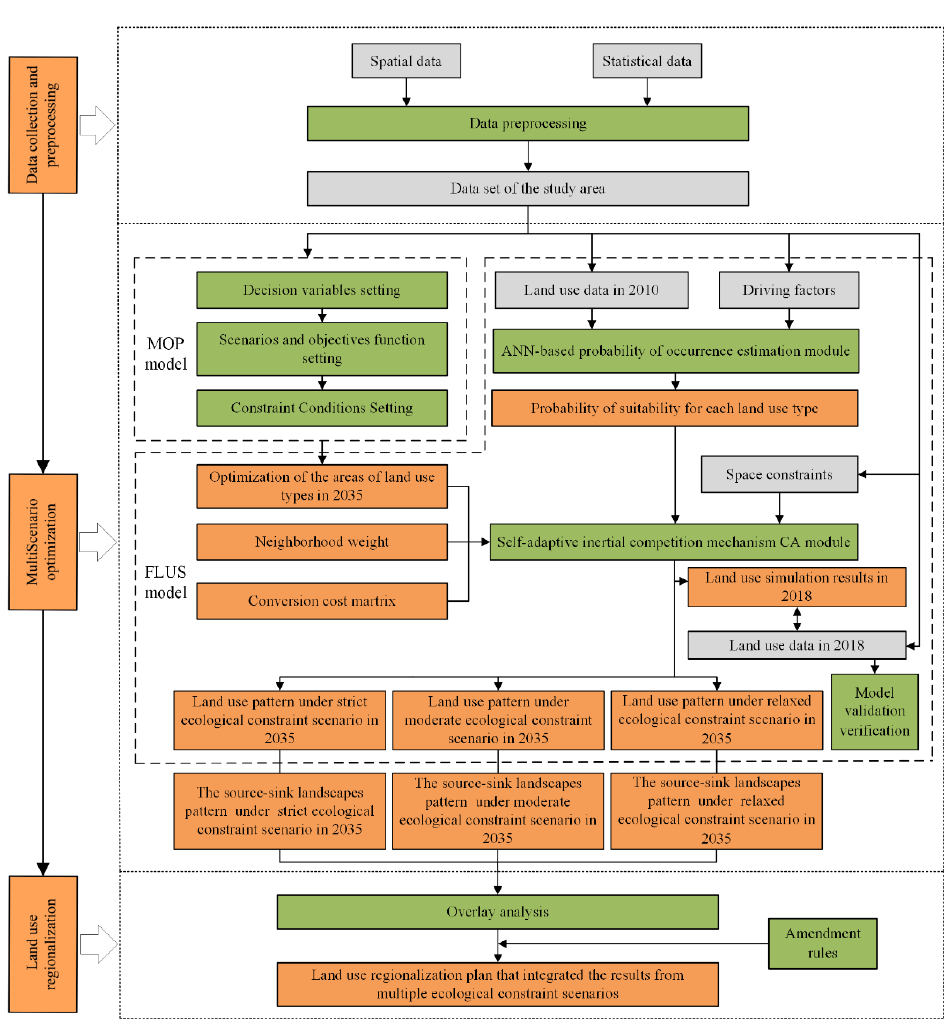
Figure 2. A flow chart of the methods applied in this study.